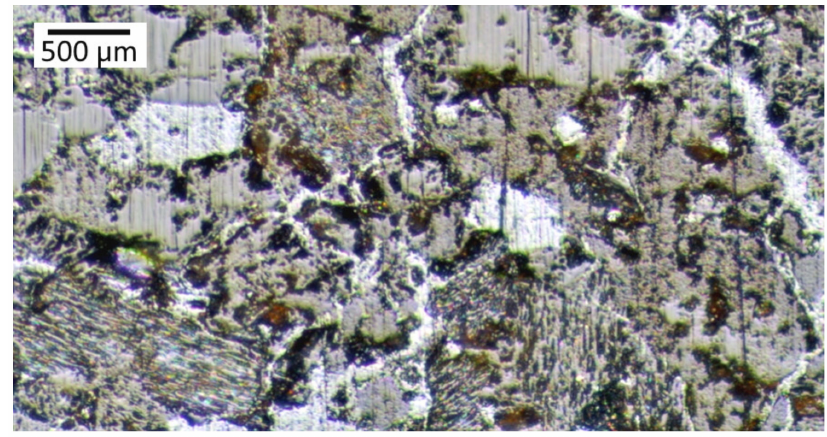
Figure 14. Typical optical micrograph of NWA 1990 stony meteorite.